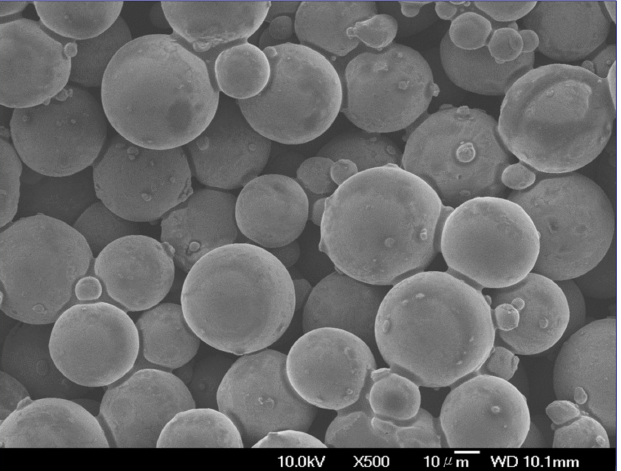
Figure 1. SEM micrograph of the NiTa powder used in this study.